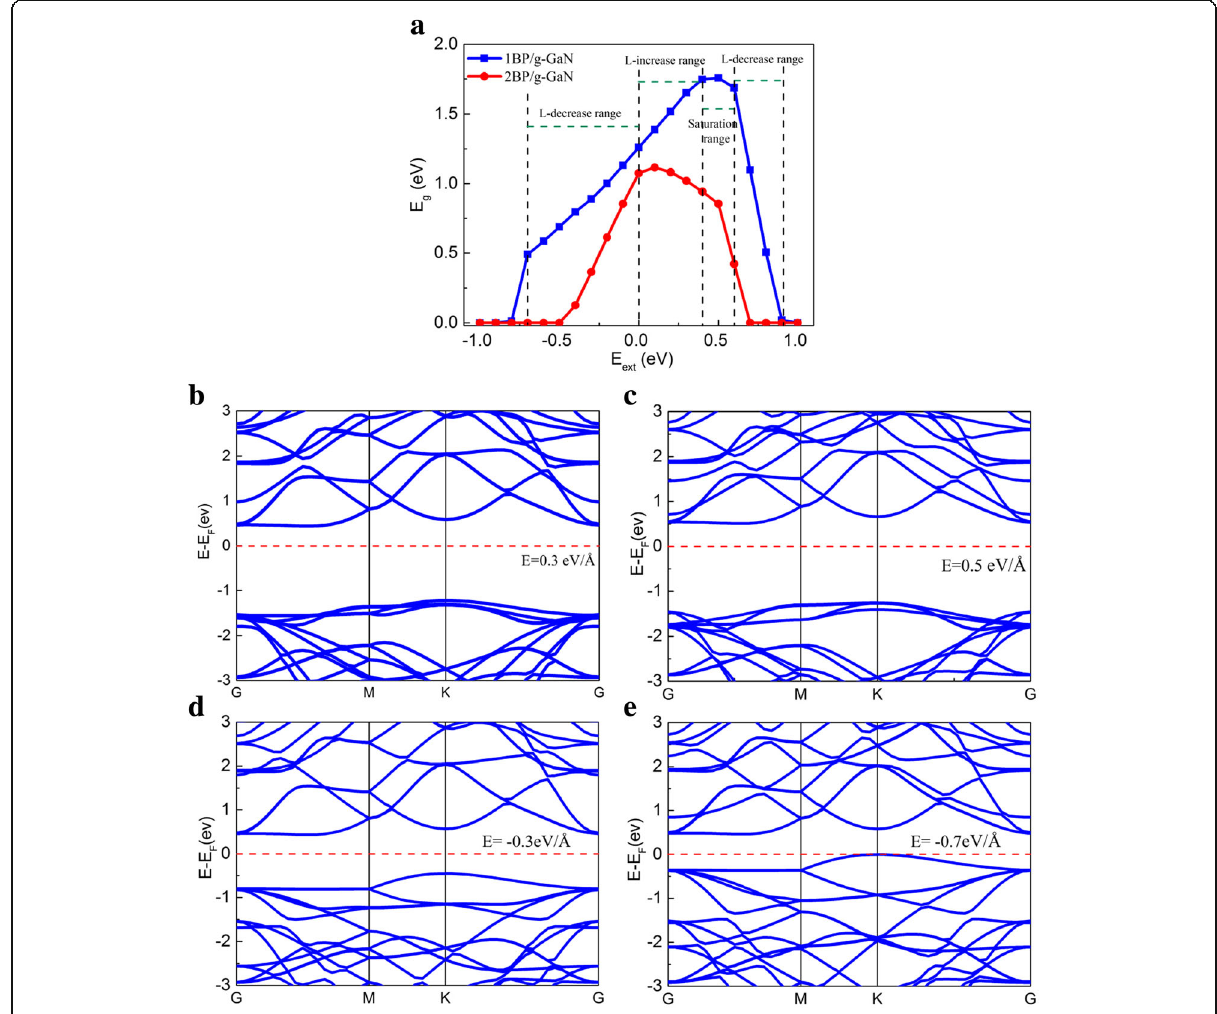
Fig. 3 a E g vs E ext of monolayer-blue-P/g-GaN and bilayer-blue-P/g-GaN heterostructures. b – e The band structures of the monolayer-blue-P/g- GaN heterostructure with E ext of 0.3 eV/Å, 0.5 eV/Å, − 0.3 eV/Å, and 0.7 eV/Å. The E F is set to 0, and indicated by the red dashed